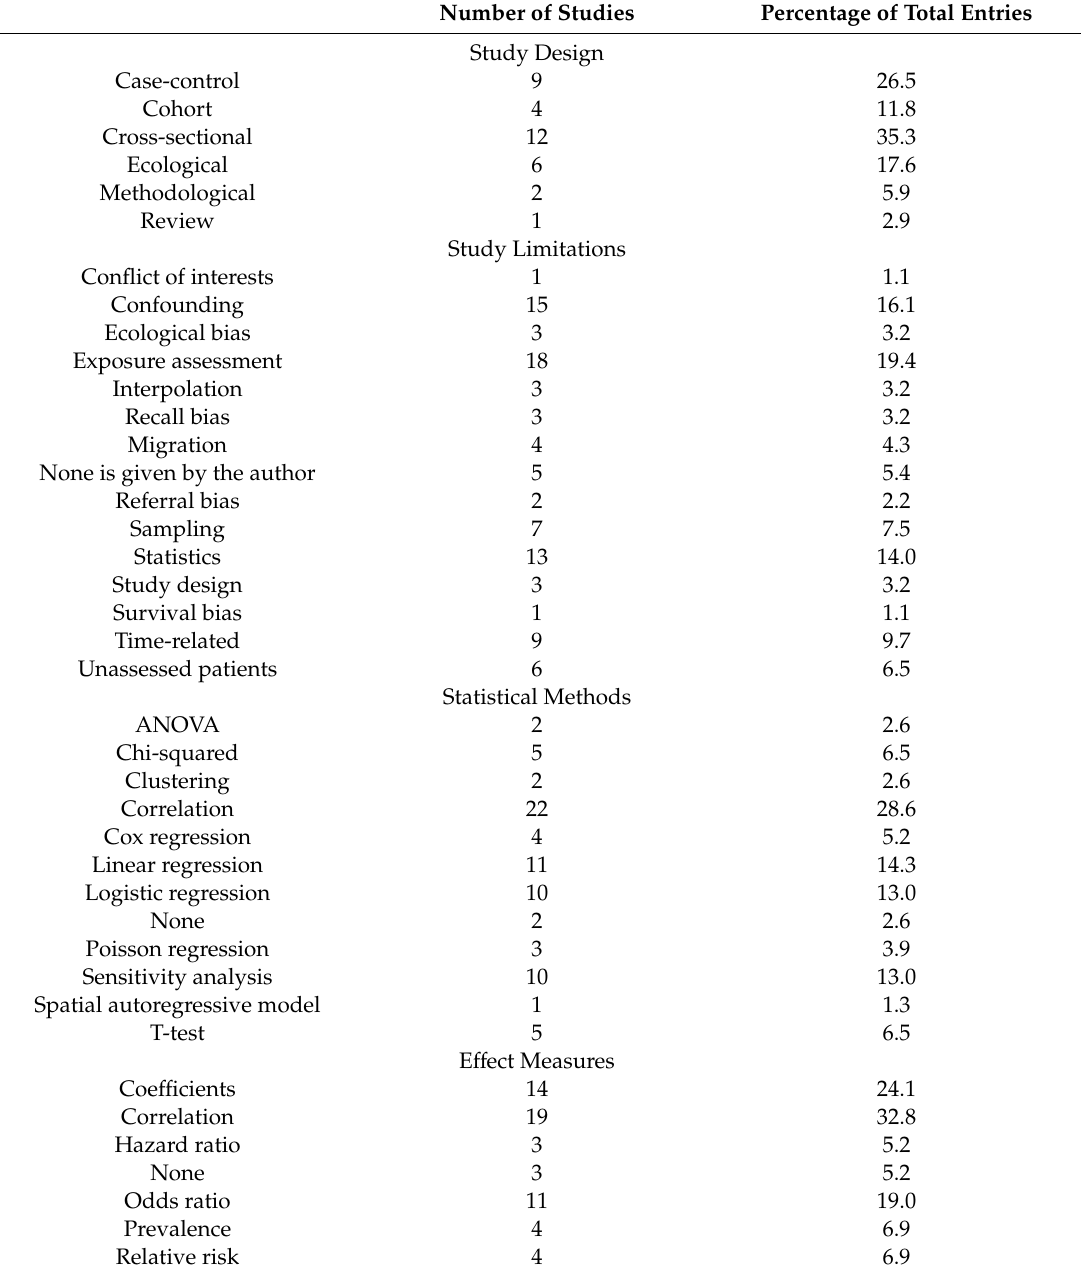
Table 2. Study characteristics summary: study design, study limitations, statistical methods, and e ff ect